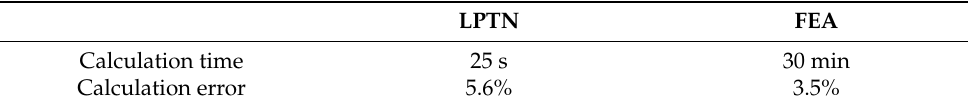
Table 5. Calculation time and error of LPTN and FEA